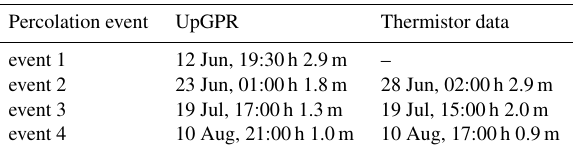
Table 2. Dates and minimum infiltration heights above the anten- nas for local minima in percolation of both, the upGPR data and thermistor records. We used the interpolated − 1 ◦ C isotherm for percolation minima of the thermistor